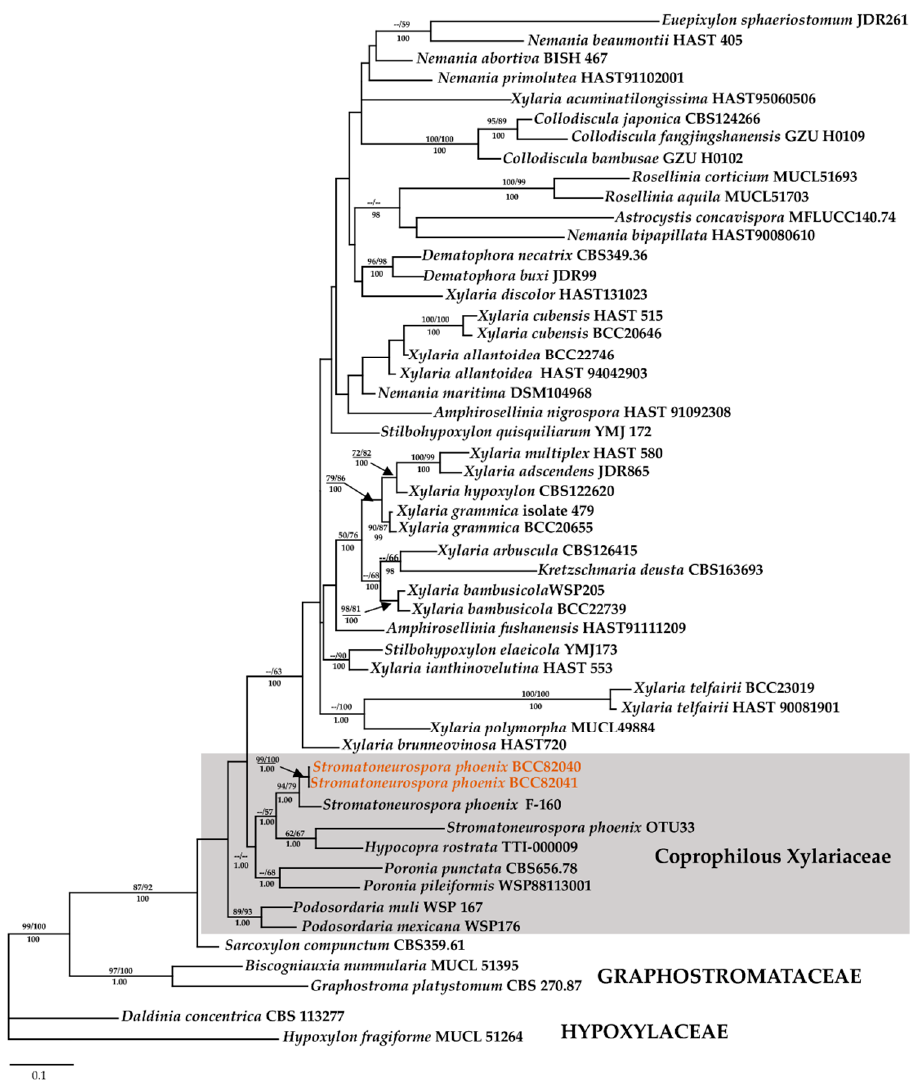
Figure 3. Phylogenetic relationships inferred from RAxML of Stromatoneurospora phoenix and other selected Xylariales based on ribosomal internal transcribed spacer (ITS) DNA sequence data. Support values of via MP, ML, and Bayesian (MB) analyses higher than 50% (MP, ML) and 0.95 (MB) and are given above (MP / ML) and below (MB) the respective branches. The black arrow indicates the sequences of S. phoenix (in orange font) and the clade comprising the sequences of the coprophilic and pyrophilic Xylariaceae is marked by a grey rectangle.